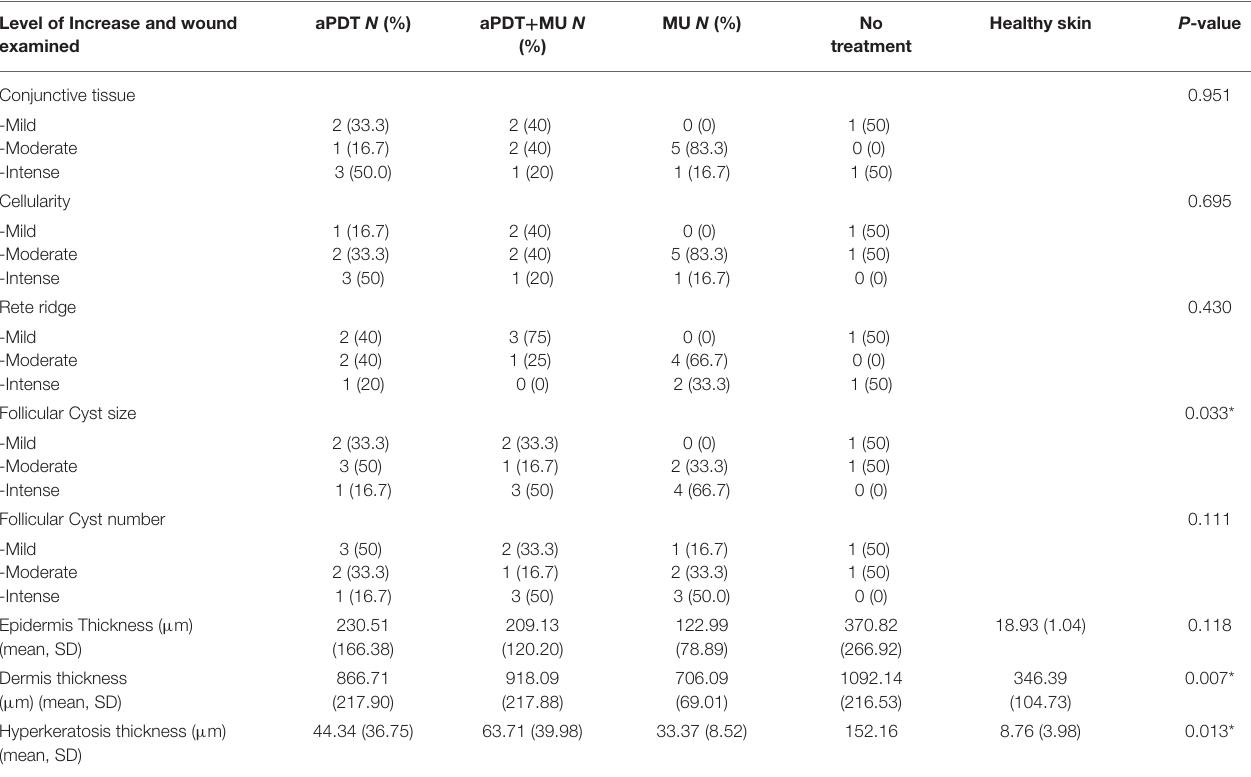
TABLE 5 | Histologic findings of wounds on therapy against untreated and healthy skin. Level of Increase and wound examined